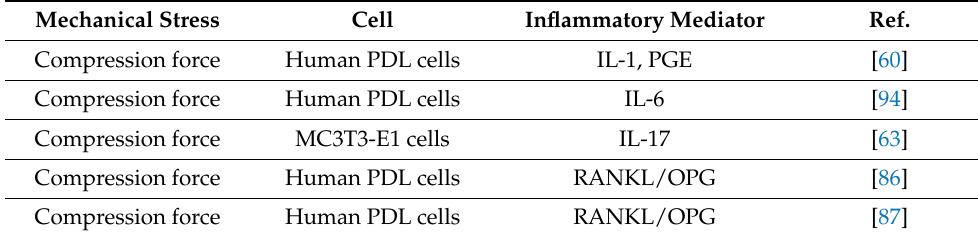
Table 1. In vitro studies in inflammation and mechanical stress.